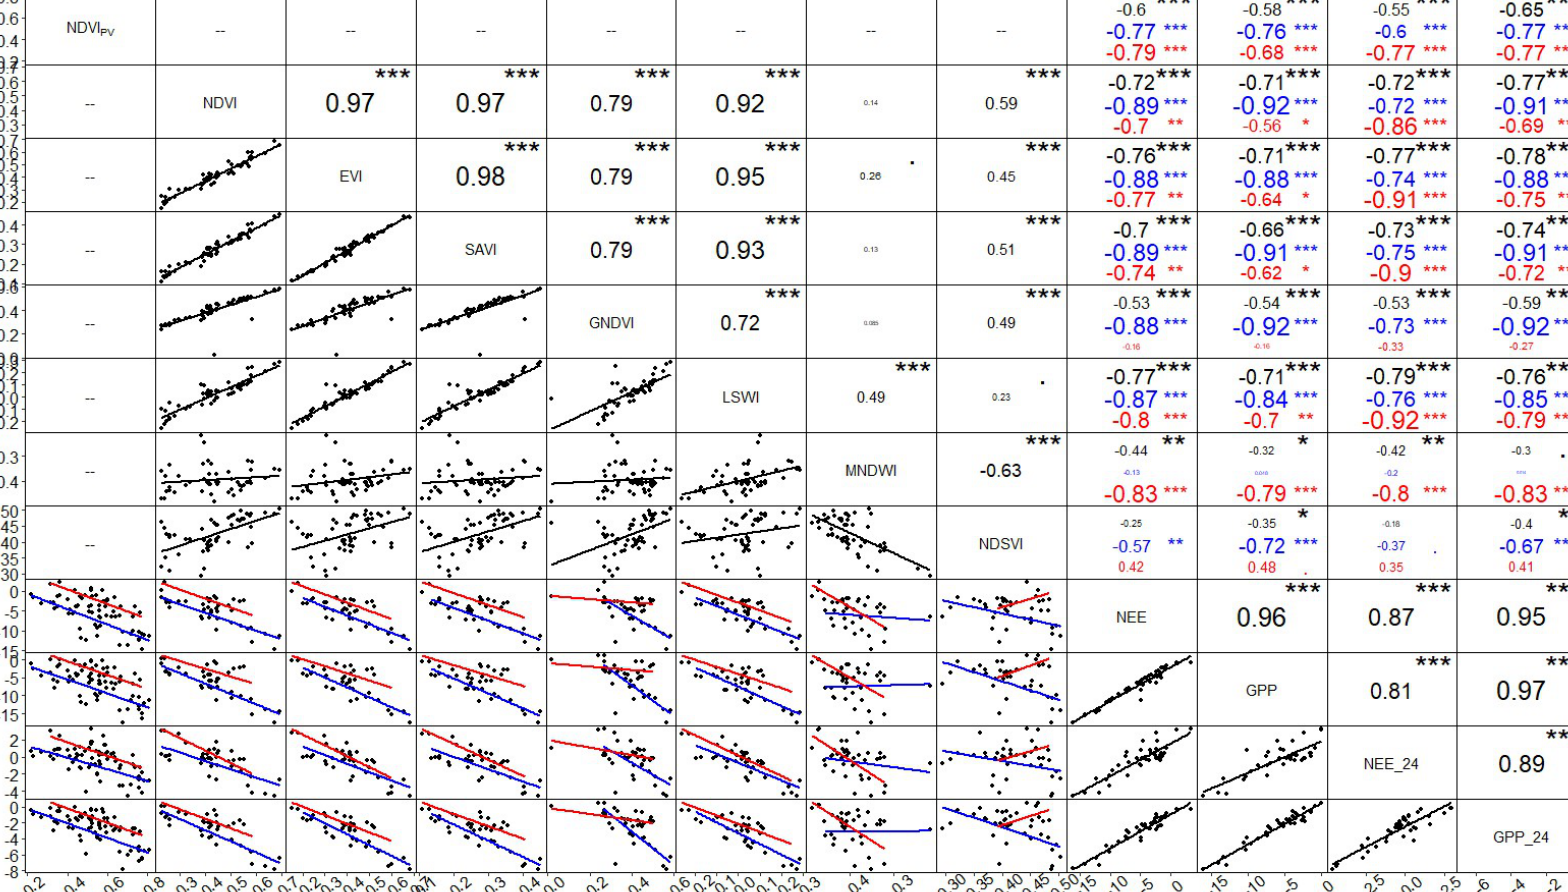
Figure 4. Correlation charts between fluxes and vegetation indices. Values in black, blue and red represent Pearson correlation coefficients for a single fit, the wet phase (VPD ≤ 1500 Pa) and the dry phase (VPD > 1500 Pa), respectively. The remark “_24” is used to distinguish daily average fluxes from midday average fluxes. *, **, *** indicates correlations significant at p < 0.05; p < 0.01 and p < 0.001, respectively.